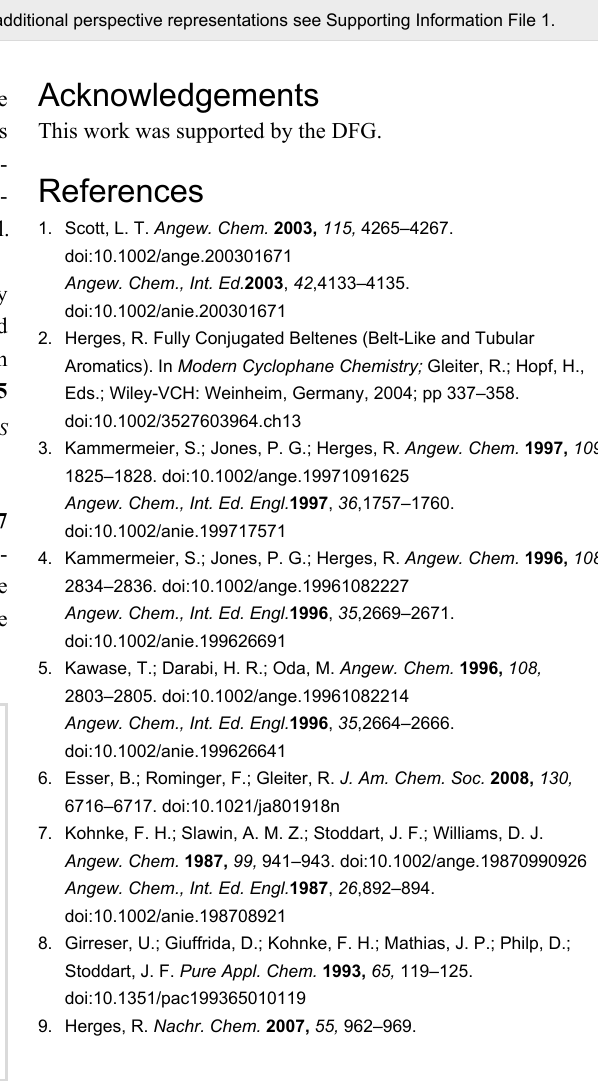
Figure 3: ORTEP drawing of the crystal structures: a) 5b and b) 6 . For additional perspective representations see Supporting Information File 1.